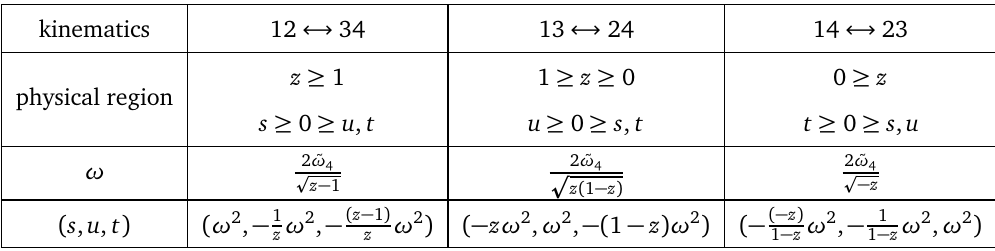
Table 1: The physical regions, center of mass energy ω and Mandelstam variables in the three different